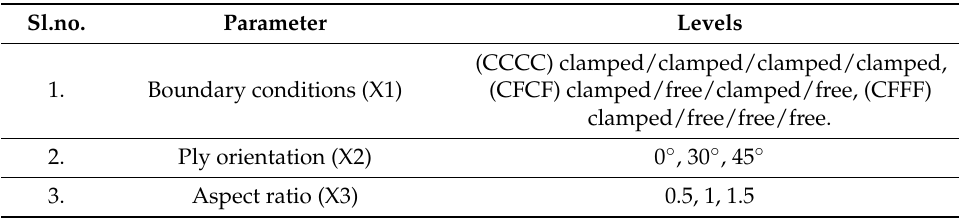
Table 1. Three parameters and its three levels.